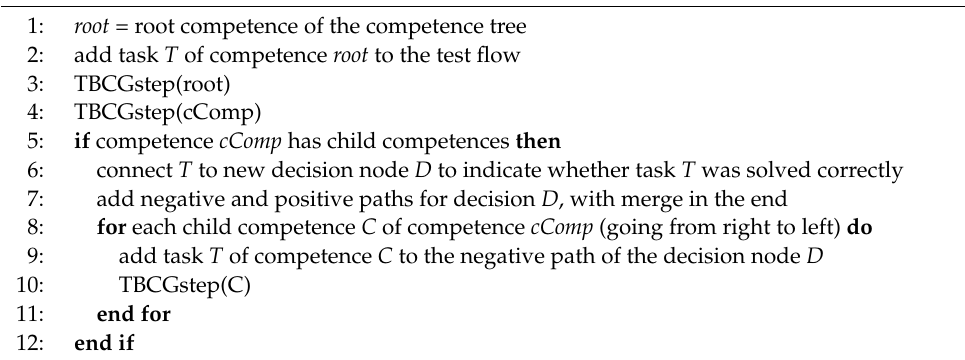
Algorithm 1 Pseudocode of TBCG transformation.